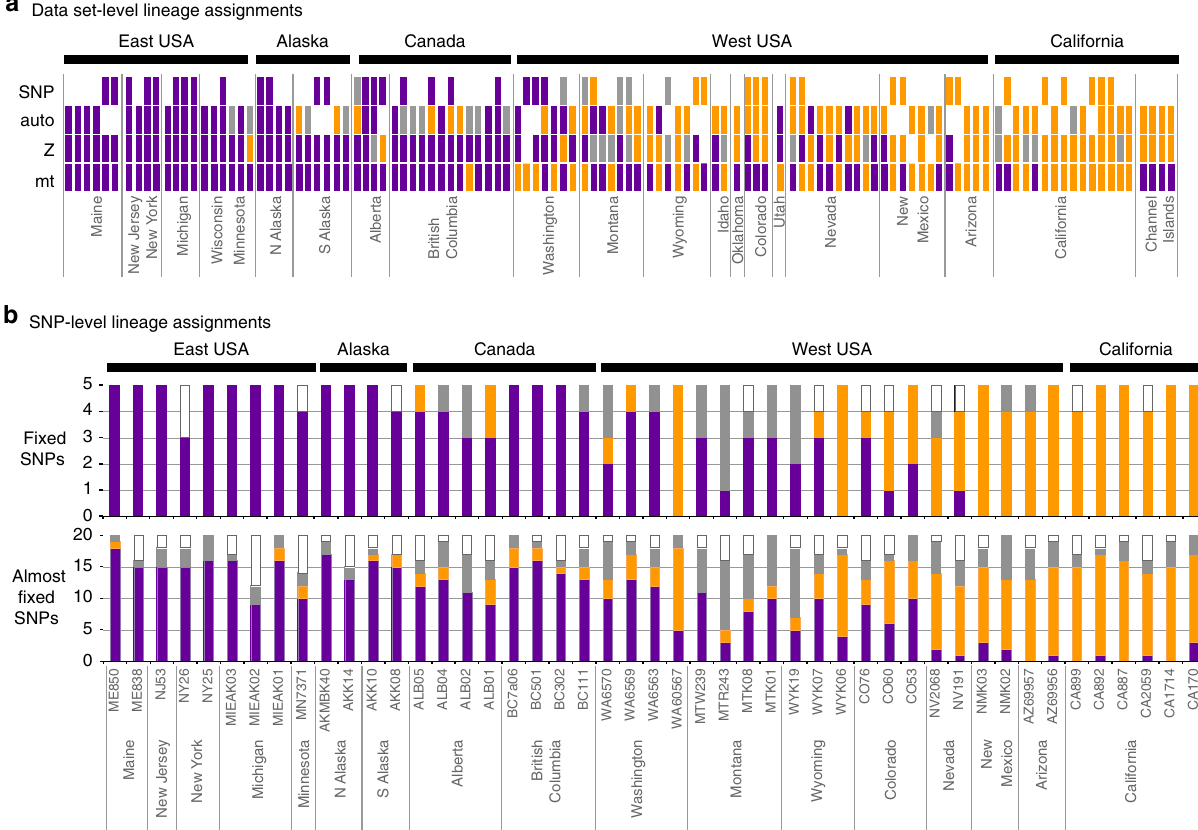
Fig. 3 Mosaic genomes and extensive admixture within Common Ravens. a Genomic pro fi les of 116 Common Ravens from North America sampled in three or more data sets. Each box represents the assignment of an individual specimen as Holarctic (purple), California (orange) or admixed California/Holarctic (grey) based on mtDNA, Z intron, autosomal introns and SNPs (acronyms: mt, Z, auto and SNP). White indicates missing information. Specimens were designated admixed if they had probability assignments under 0.7 for both Holarctic and California clusters in STRUCTURE analyses of autosomal introns and SNPs, and were heterozygote at the A/G SNP in the Z intron. b California/Holarctic assignment for SNPs that was fi xed ( F ST = 1; n = 5 SNPs) or almost fi xed ( F n = 20) between pure individuals from the California and Holarctic lineages ST > 0.58;